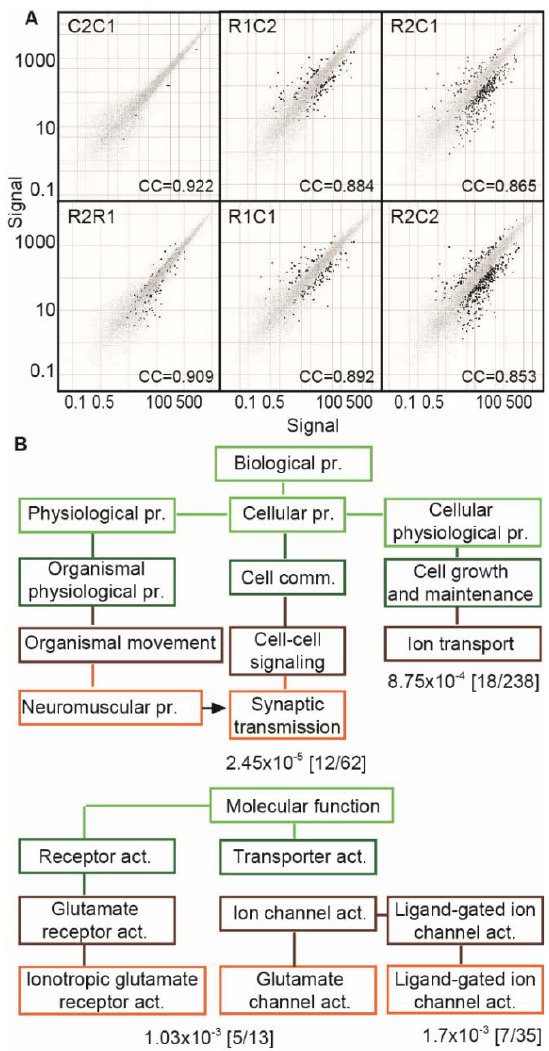
Figure 7. Glutamatergic transcripts are conspicuously changed in the TgR PFC. ( A ) Log10 Scatter plots demonstrating greater differences between microarray pools of 4 TgR mice PFCs (R1 R2) as compared with pools of 4 FVB/N mice PFCs (C1 C2), and yet greater differences between cross pools (R1 C2, R2 C1, R1 C1, R2 C2). Gray dots depict genes the expression level of which was unaltered between the two tests; black dots depict genes with log ratio higher than 1. ( B ) GOC pathways terms modified in TgR mice relative to parent strain mice. Terms for the biological process and molecular function are shown at the top and bottom, respectively. The lines indicate the hierarchical relationship between the terms. Values indicate the probability to observe the given number of changed transcripts within a term by chance. PFC = prefrontal cortex; GOC = gene ontology categories; pr = process; comm. = communication; act = activity.